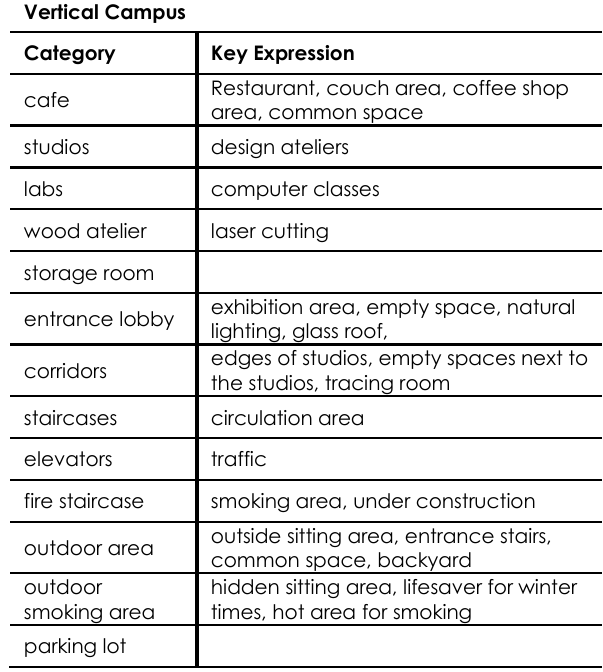
Table 5. Categories and key expressions of subjects for photography on vertical